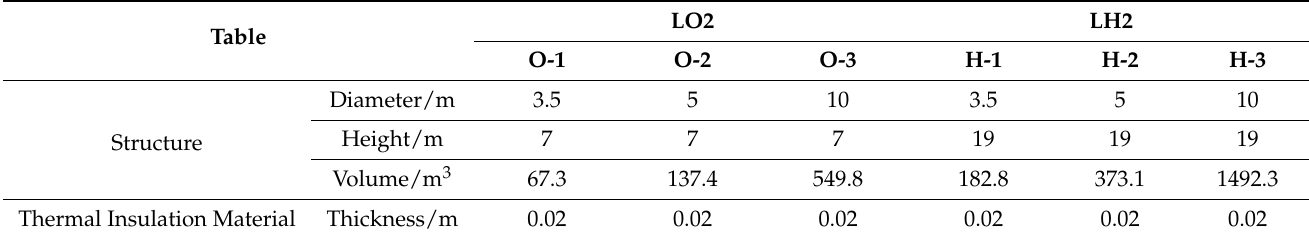
Table 1. Parameters of the rocket tank